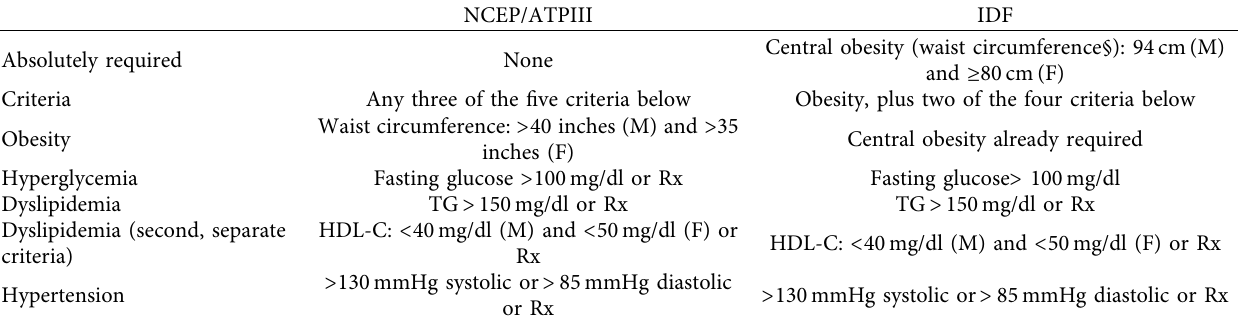
Table 1: Definitions of metabolic syndrome by using NCEP/ATPIII and IDF